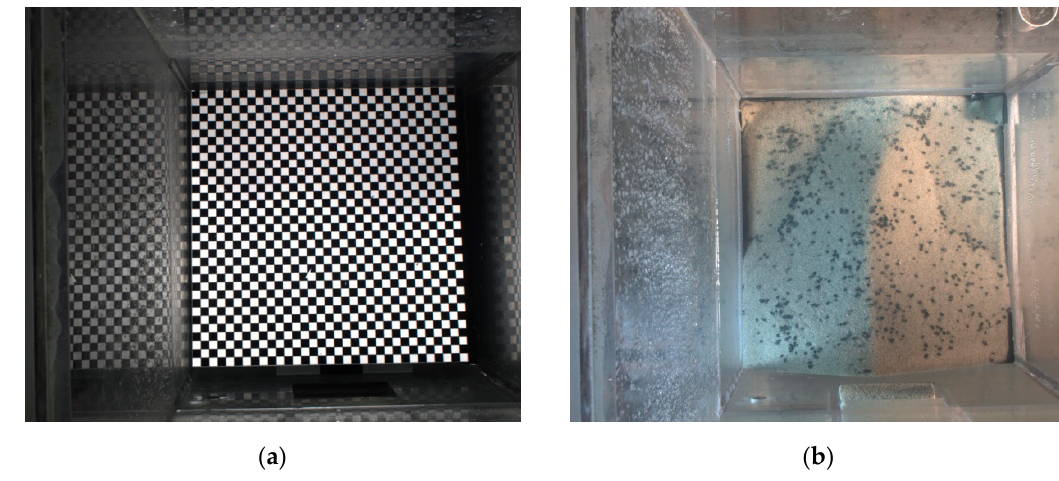
Figure 7. ( a ) Image used to calibrate the stereo photography setup; ( b ) Image of the sediment bed used to create the artificial sediment bed shown in Figure 6b.